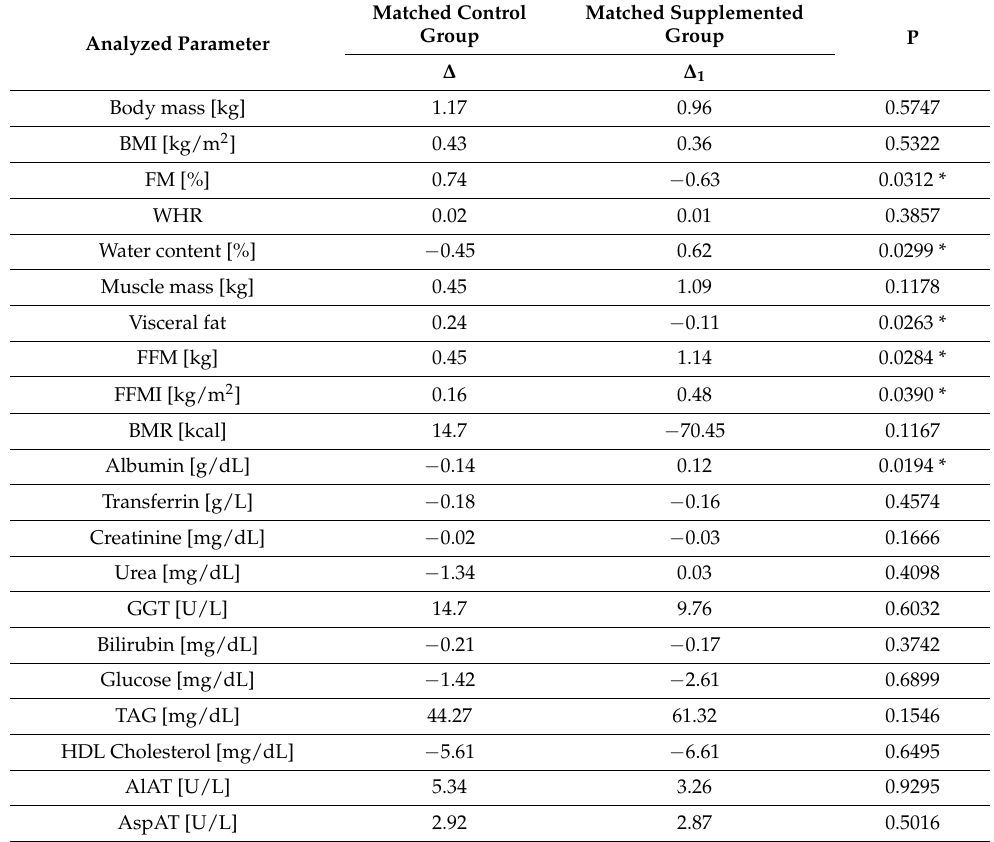
Table 3. Comparison of changes (before and after 6-week chemotherapy) for anthropometric and biochemical parameters between the matched supplemented group and control.